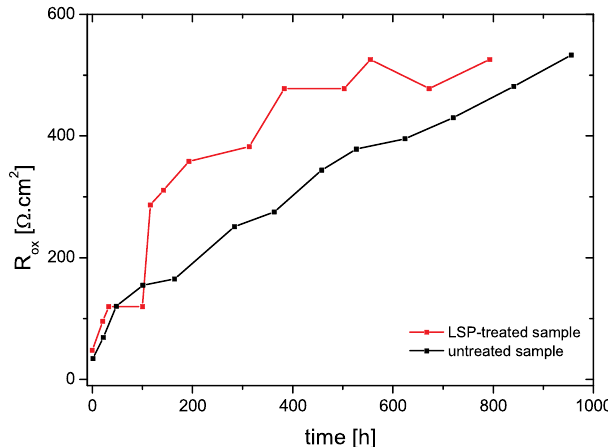
Figure 9. Time evolution of oxide resistance R ox of untreated and LSP-treated SS 304L.